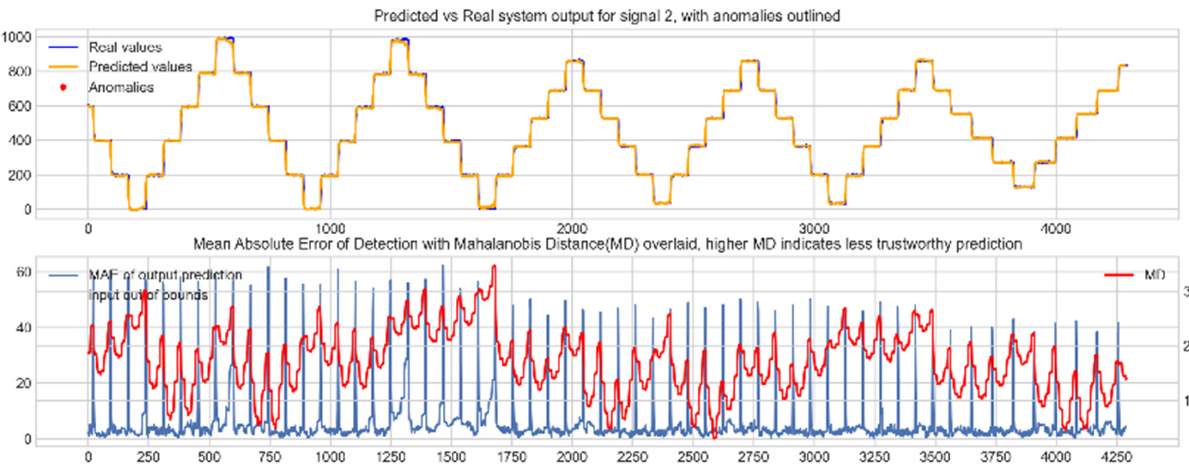
Figure 14. Predicted vs. real device input for signal 1, the right elevon, with anomalies labelled ( top ); MAE, MD and boundary check corresponding with the prediction ( bottom ).